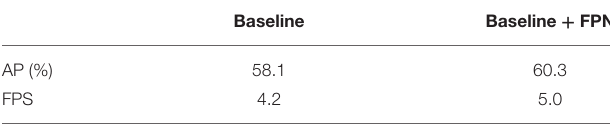
TABLE 1 | Effect of feature pyramid networks of the detection system.